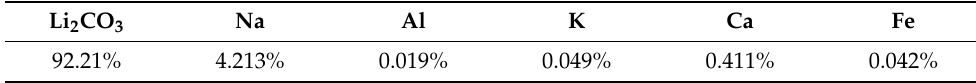
Figure 1. Flowsheet developed for the recovery of battery-grade Li 2 CO 3 from the lithium-containing desorption solution. Table 2. Impurity content of primary lithium carbonate products.